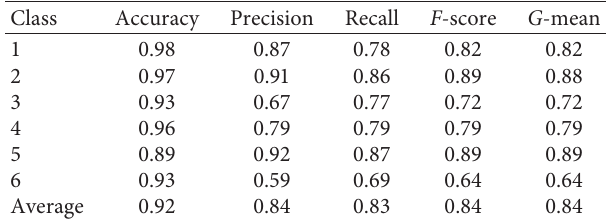
Table 3: Performance scores achieved in classification of testing dataset. The average values are weighted by the number of data in each